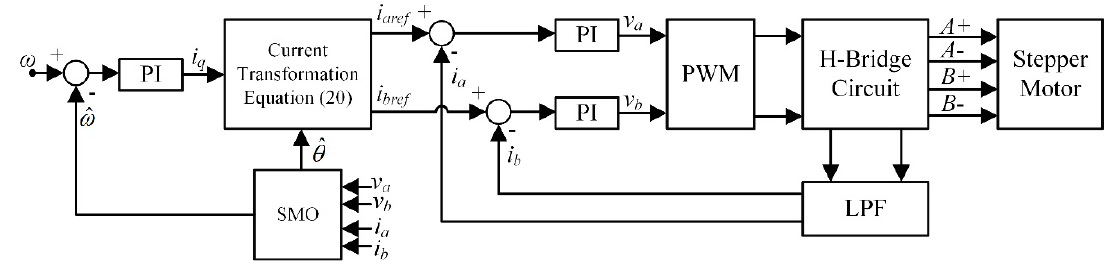
Figure 4. Block diagram of the new sensorless speed control of a stepper motor.